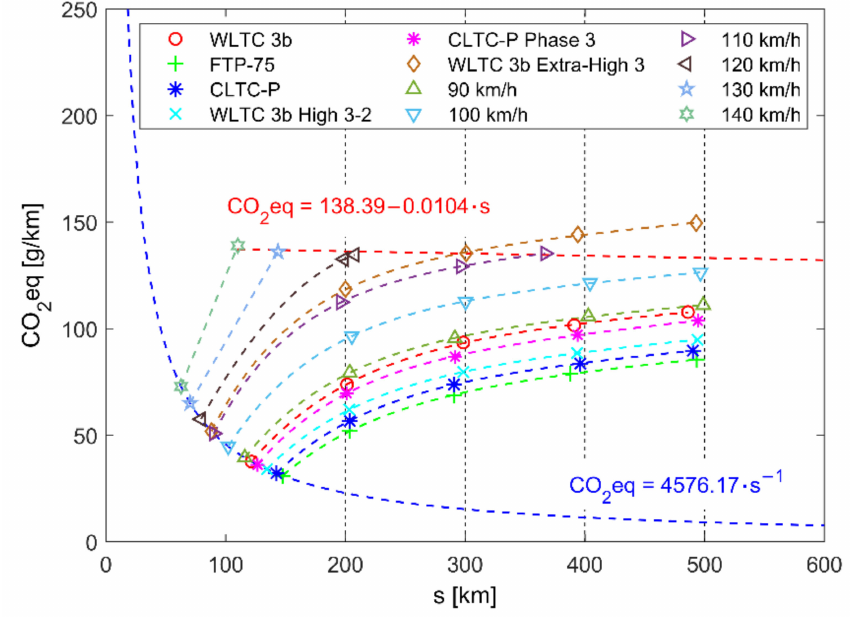
Figure 14. Combined CO 2 eq emission, due to EREV operation and electricity production (EU-27), in various driving conditions. Note that the blue approximation line (BEV mode) and the red approximation line (maximal range) are obtained for constant speed driving results from the range of 90–140 km/h.